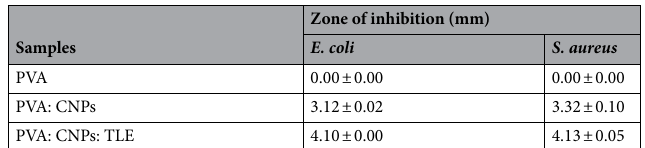
Table 2. Antimicrobial activity of PVA, PVA: CNPs, PVA: CNPs: TLE. The data are presented as the mean ± SD of three individual experiments.